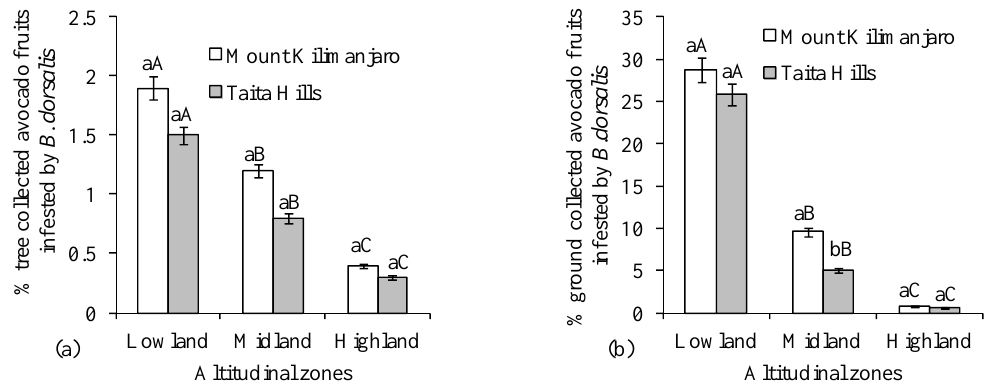
Figure 3. Percent infestation (Mean ± SE) by Bactrocera dorsalis of avocado fruits ( a ) picked from the tree and ( b ) collected from the ground along altitudinal zones of Taita Hills and Mount Kilimanjaro transects. Bars capped with the same lowercase letters within the same altitudinal zone are not significantly different, while bars capped with similar uppercase letters for the same transect are not significantly different.